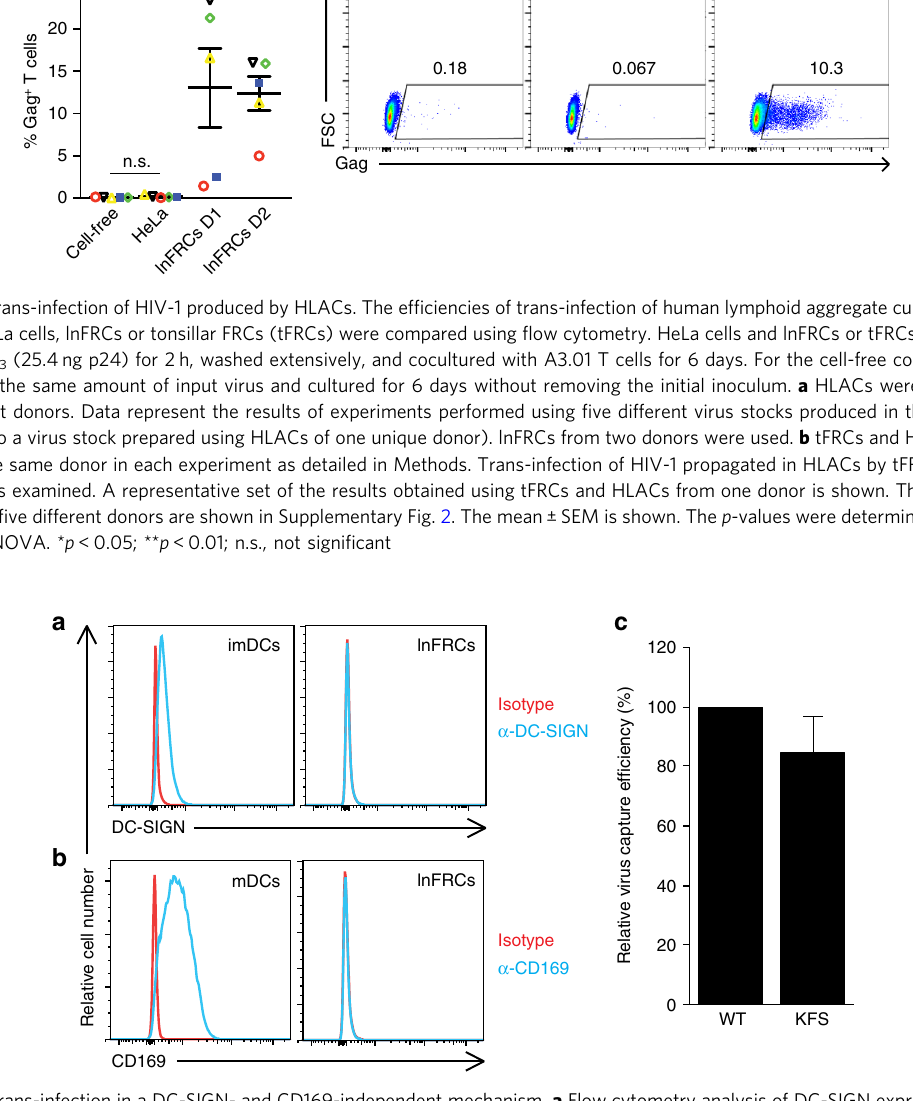
virus than with 293T-derived virus (Fig. 5c). These results suggest a possibility that HIV-1 incorporates molecule(s) important for FRC-mediated trans-infection, which is differentially expressed between HeLa and 293T cells.